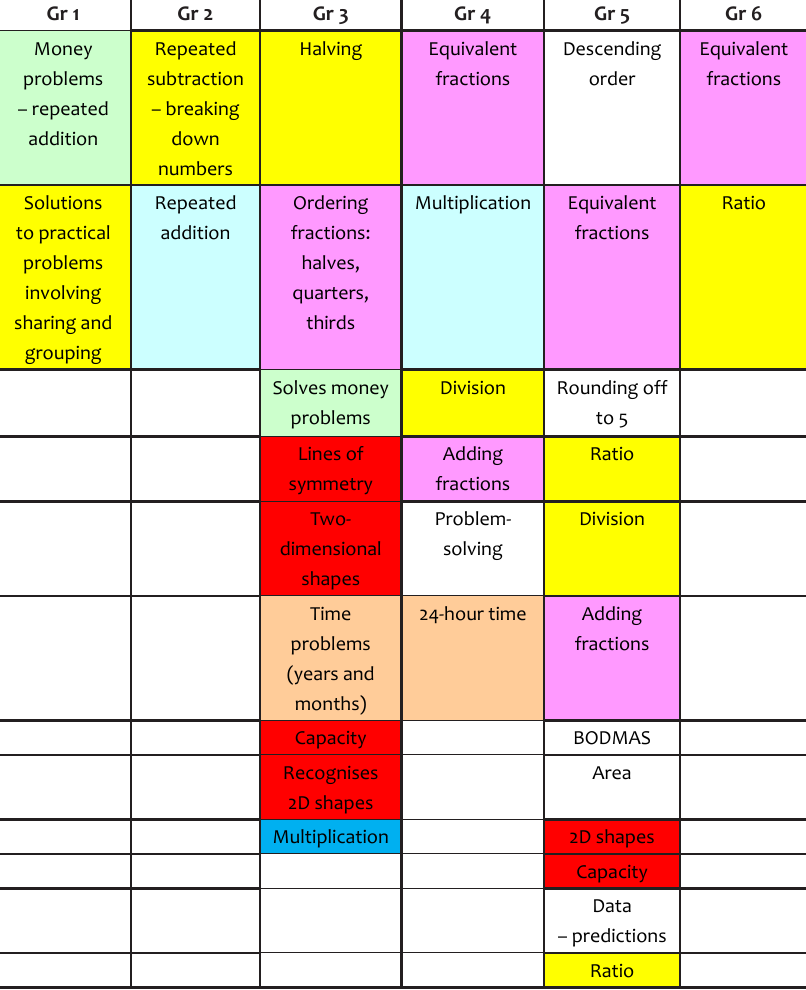
Figure 6: Colour coded sheet for identifying areas of weakness (maths teacher) Gr 1 Gr 2 Gr 3 Gr 4 Gr 5 Gr